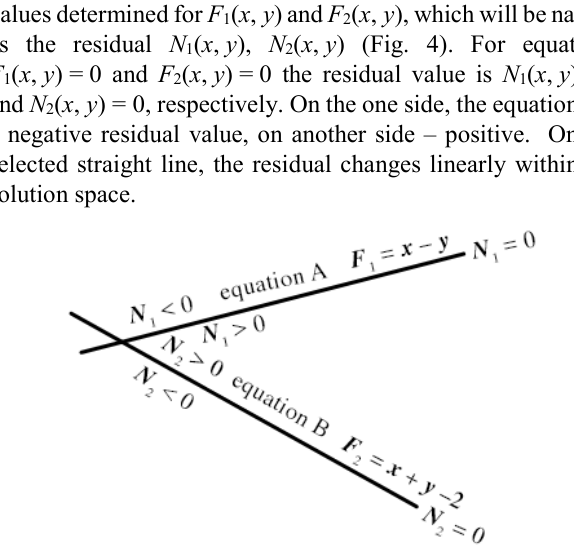
Fig. 4. Residual N 1 and N 2 value operators in the sectors of the calculated